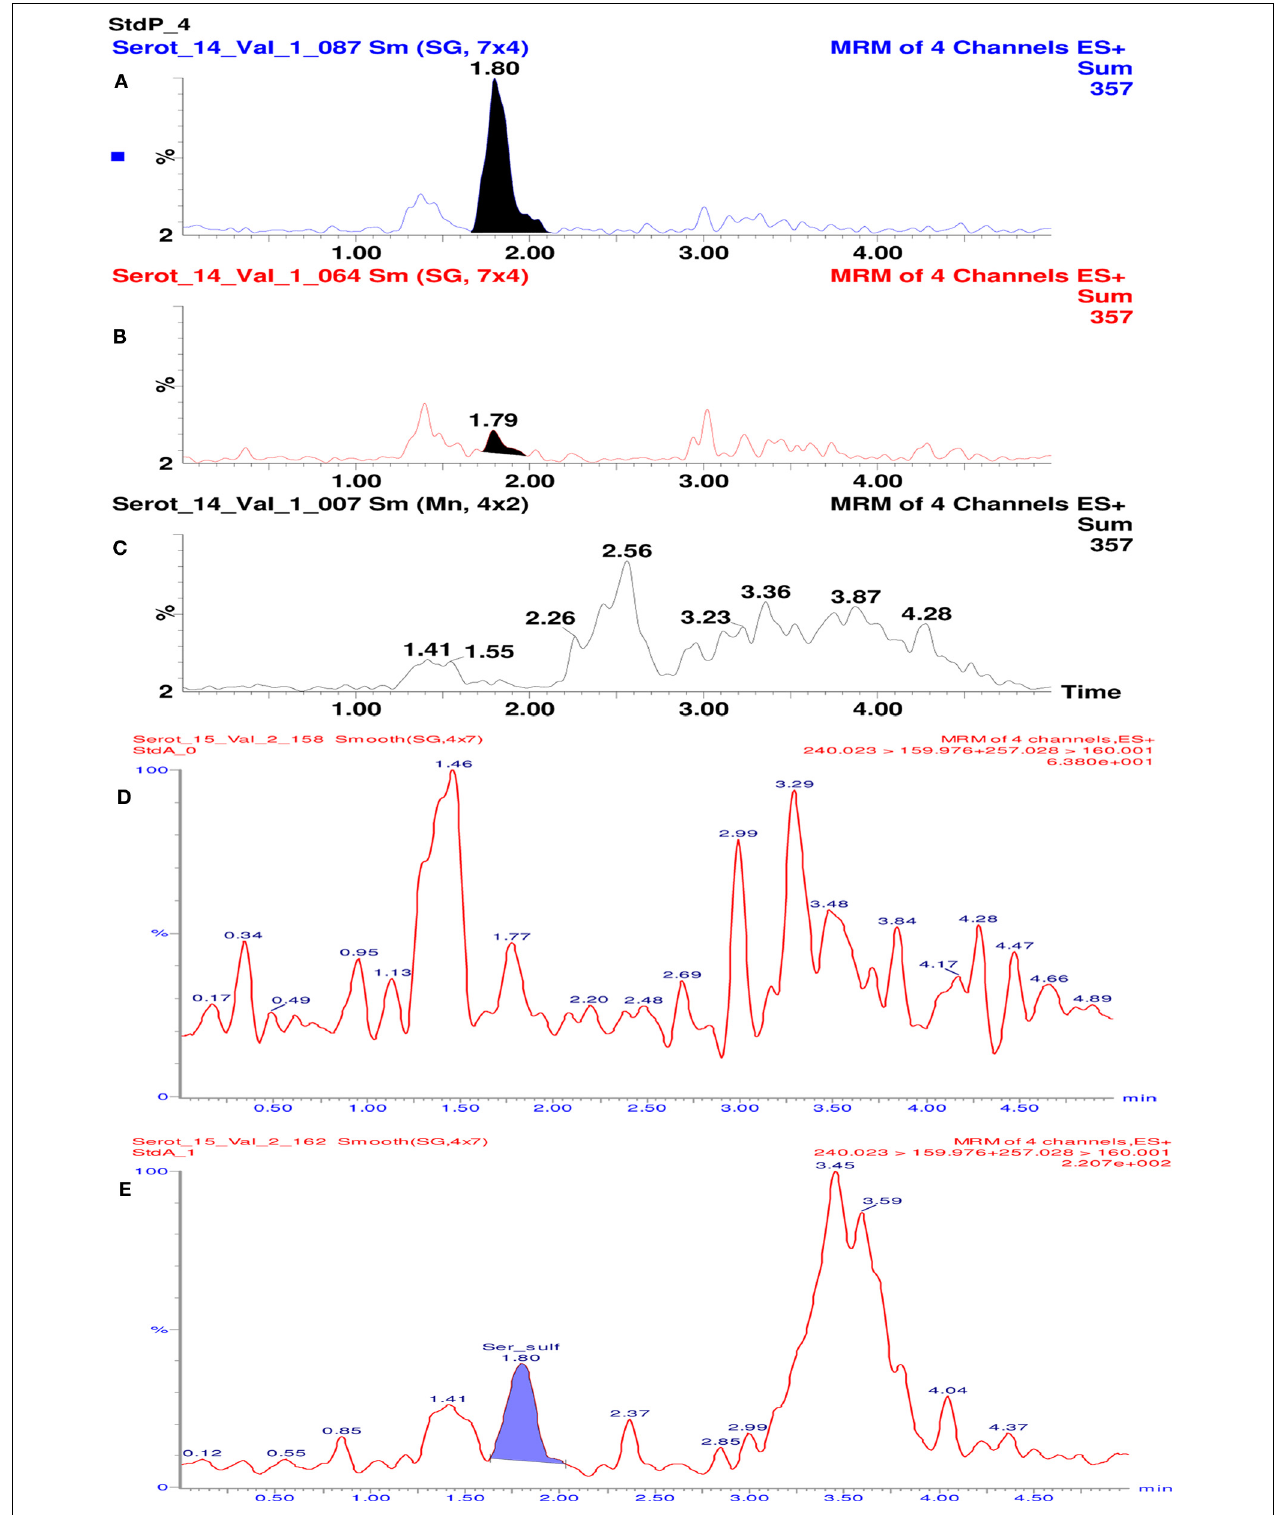
FIGURE 2 | Chromatograms of 5-HT-SO4 samples and MRM chromatograms. The (A) shows plasma standard solution (containing 96ng/mL of 5-HT-SO4) where 1.80min retention time peak is seen; (B) – in the “pure” plasma 1.8min retention time peak is seen; (C) – purified water where no 1.79–1.80min peak is observed. (D) shows